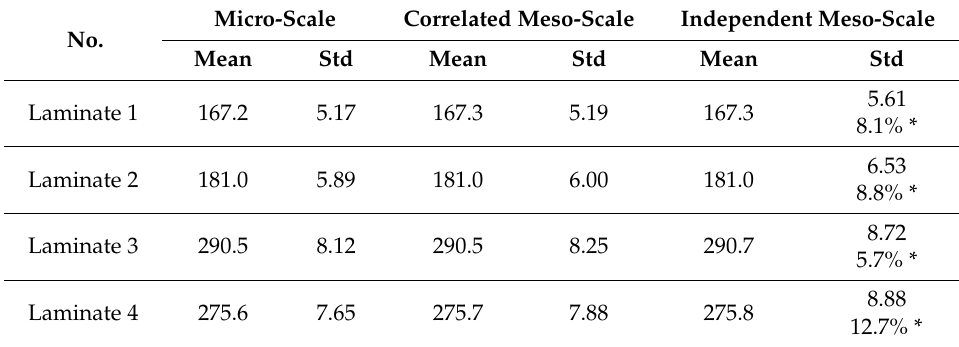
Table 4. Statistics of first order natural frequencies of laminate plate (unit in